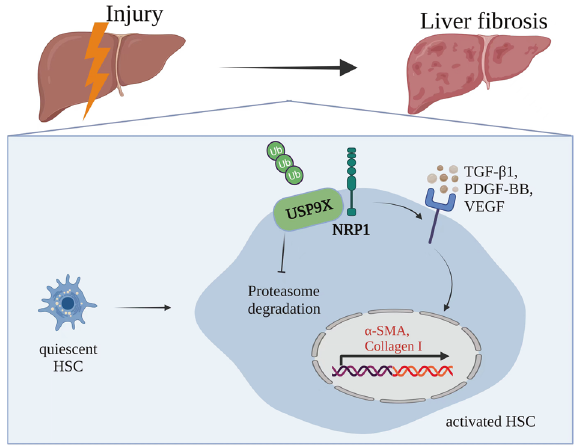
Fig. 7 The molecular mechanism underlying USP9X-mediated NRP1 deubiquitination enhances liver fi brosis by triggering HSCs. NRP1 is stabilized and upregulated by the deubiquitinase USP9X. Increased NRP1 levels promote HSC activation and the secretion of elevated levels of ECM and in fl ammatory factors through cytokine TGF- β 1, VEGF and